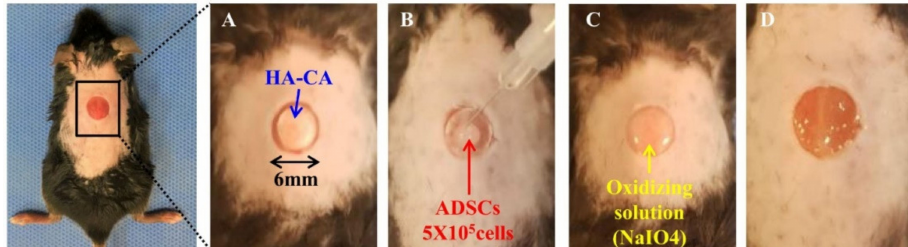
Figure 7. HA-CA and ADSC transplantation in the DBW mouse model. ( A ) HA-CA was transplanted into the 6 mm DBW, and ( B ) ADSCs (5 × 10 5 cells) were deposited onto the HA-CA. ( C ) Oxidizing solution (NaIO 4 ) was sprayed onto the cell-loaded HA-CA patch. ( D ) The crosslinked HA-CA patch was washed with phosphate buffered